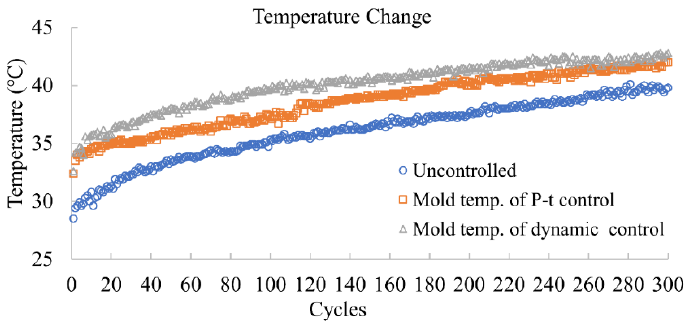
Figure 16. Natural mold temperature changes over 300 cycles of consecutive molding.